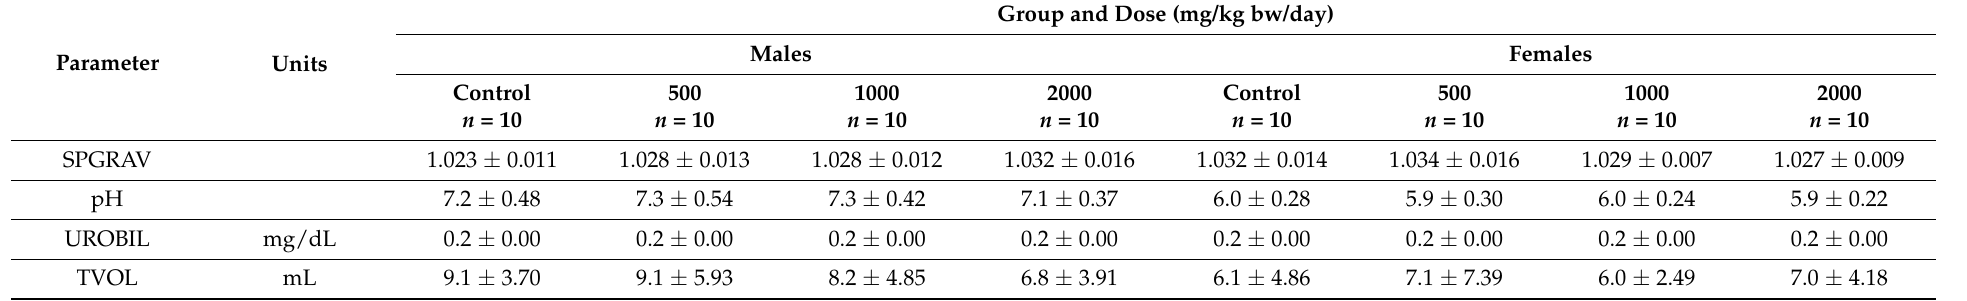
Table 5. Effect of 14 day oral administration of B. subtilis MB40 on urinalysis parameters in male and female rats.